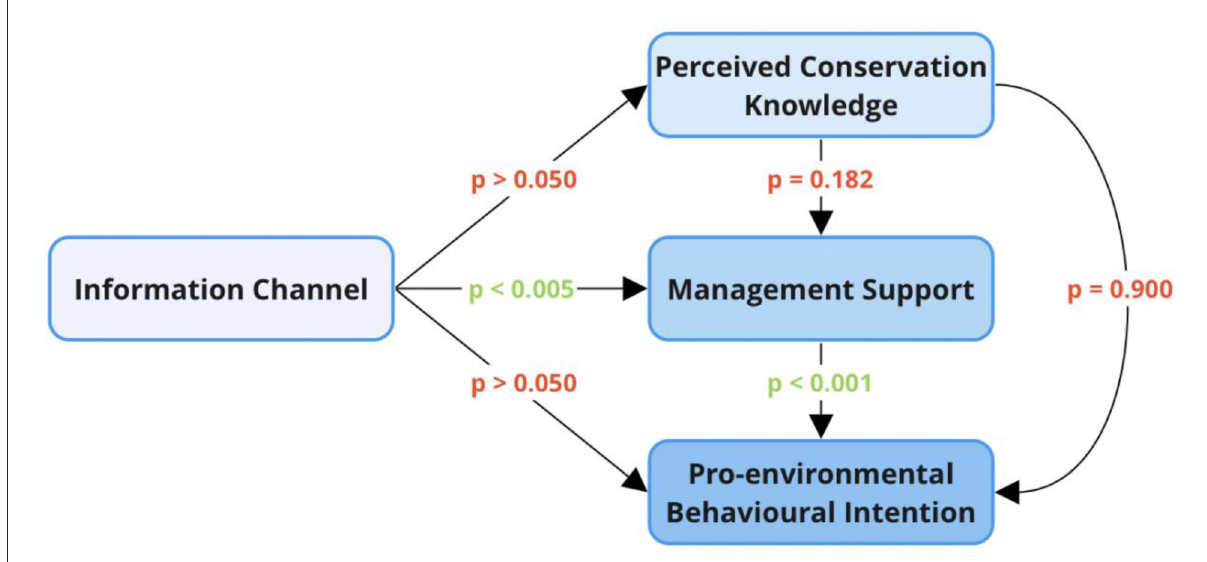
FIGURE3 Conceptual flowchart demonstrating the statistical relationships between tested variables. P -values from the three binary logistic regression models are shown in red (not significant) and green (significant) colored text for clear